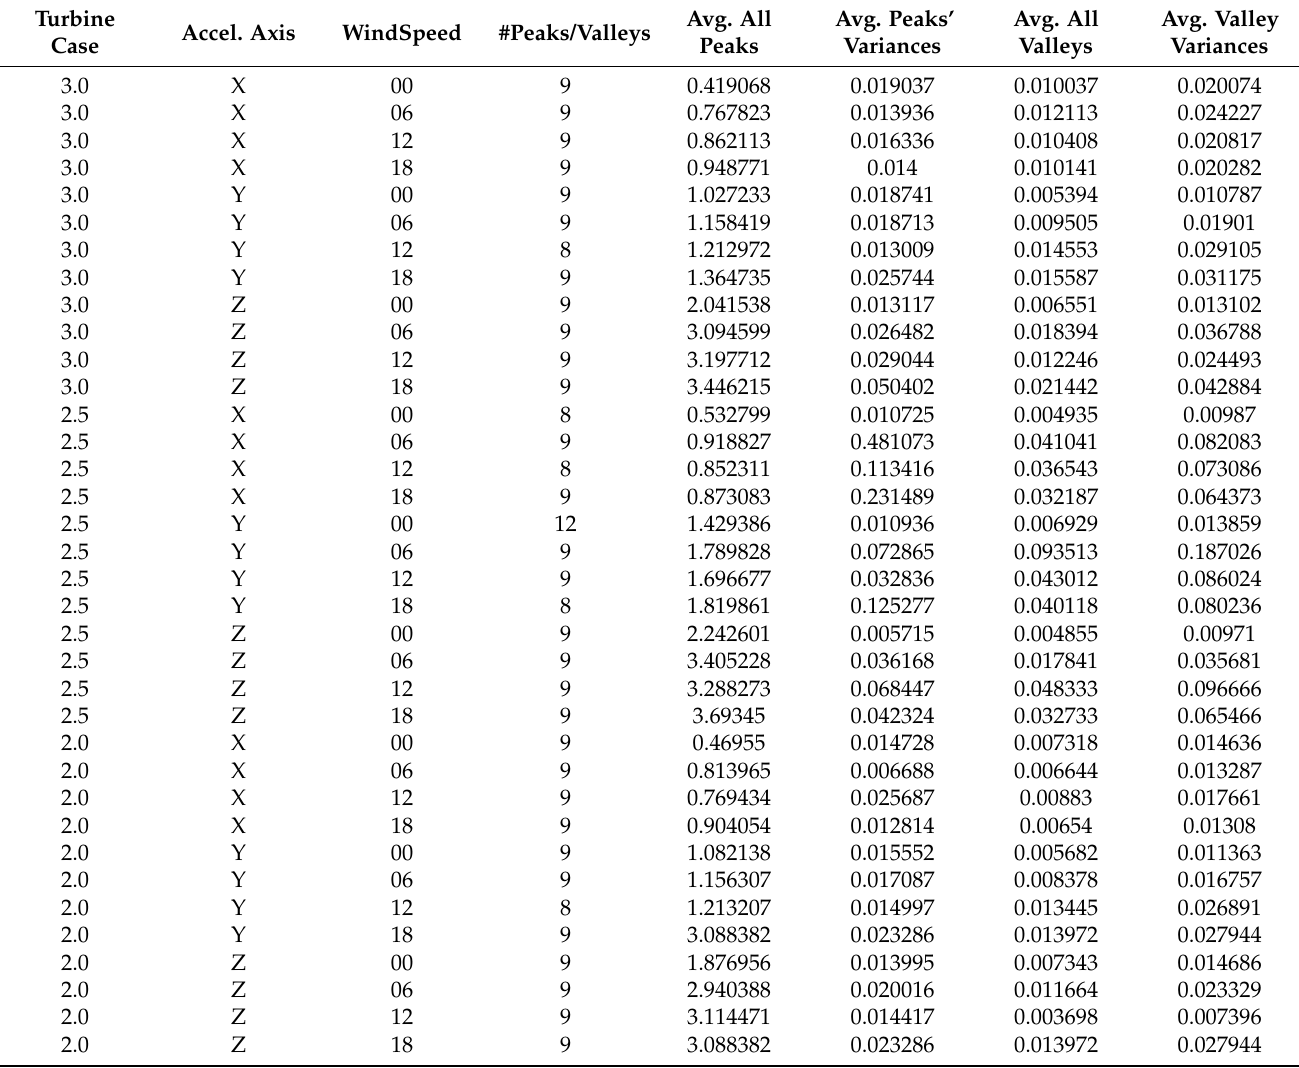
Table 3. Summary for peak/valley information for all